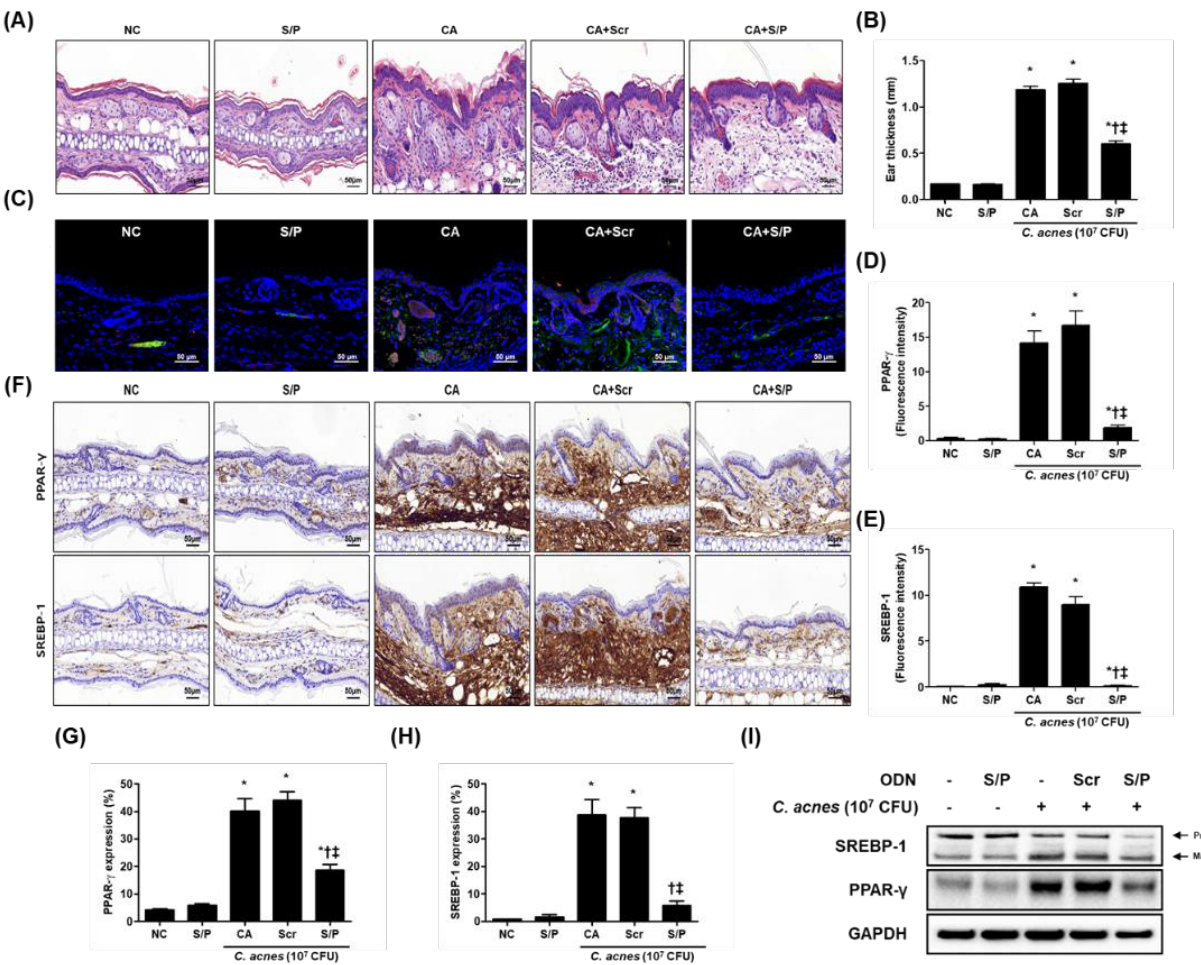
Figure 2. The SREBP/PPAR chimeric decoy ODN reduced the inflammatory infiltration and activities of the lipogenic transcription factors. ( A ) Images for histopathological inflammation severity through H&E staining. ( B ) Ear thickness. ( C ) Immunofluorescence double staining images of ( D ) SREBP- 1 (Alexa Fluor 555, red) and ( E ) PPAR- γ (Alexa Fluor 488, green). DAPI (blue)-stained nuclei. ( F ) Immunohistochemical staining was used to evaluate the extent of PPAR- γ and SREBP-1 expression, which was subsequently quantified ( G , H ). ( I ) The protein levels for SREBP-1 and PPAR- γ by Western blot analysis. * p < 0.05 compared with the NC. † p < 0.05 compared with the CA. ‡ p < 0.05 compared with the